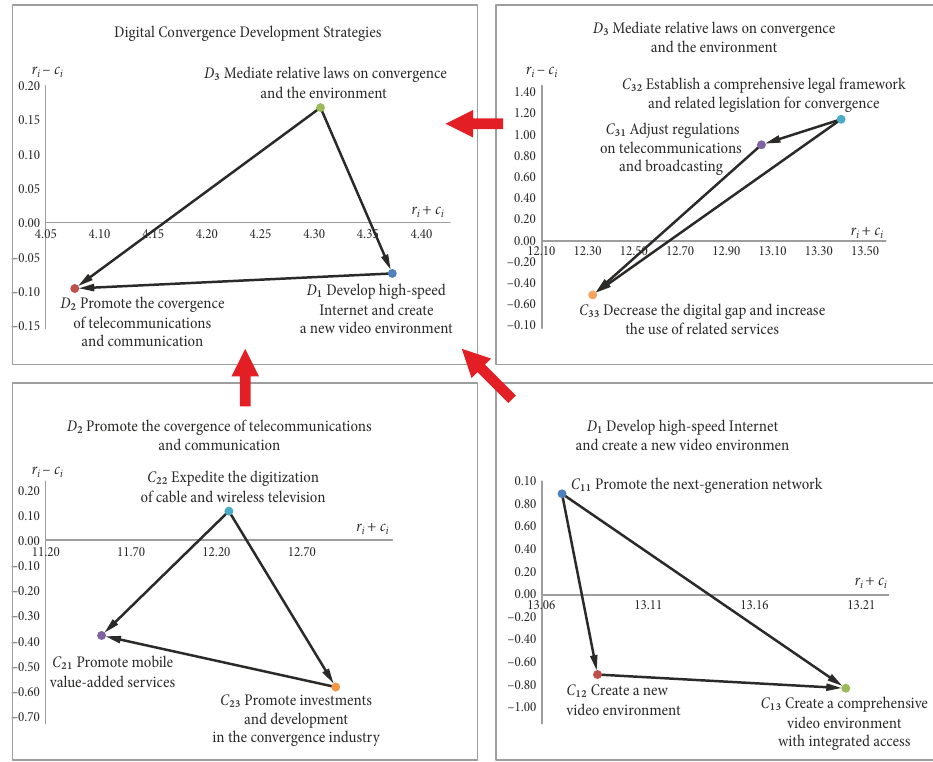
Fig. 3. Influential-network relationship map (INRM) of digital convergence for improvement